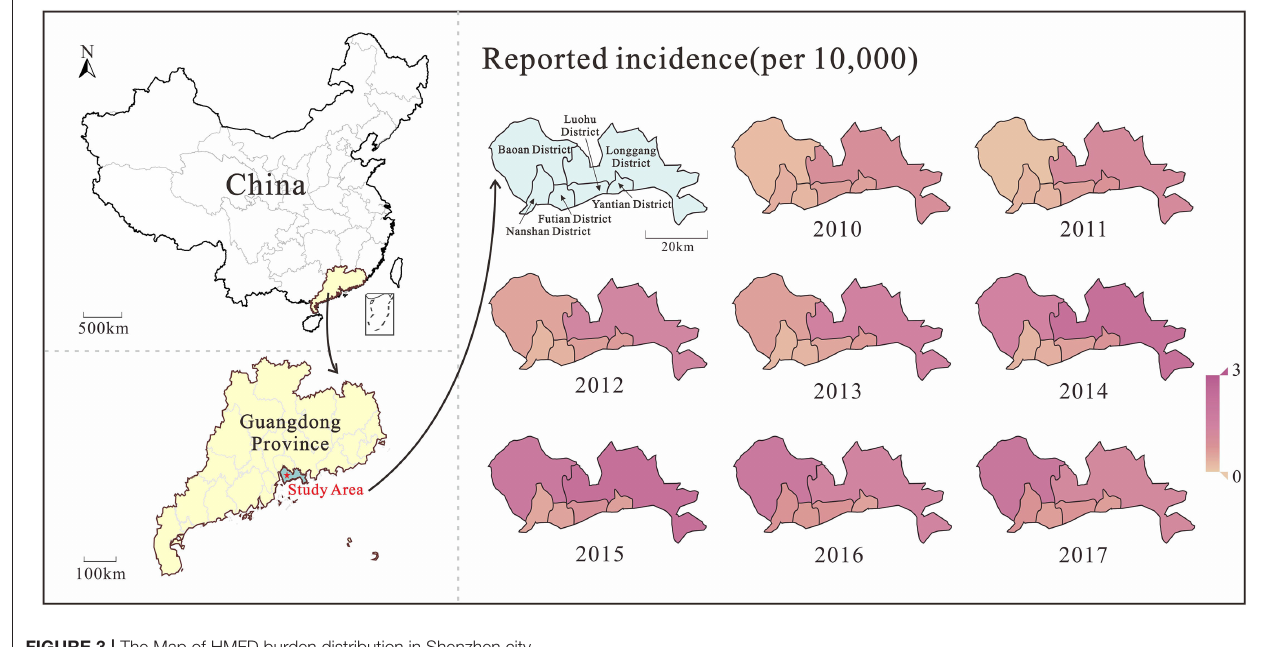
FIGURE 3 | The Map of HMFD burden distribution in Shenzhen city.